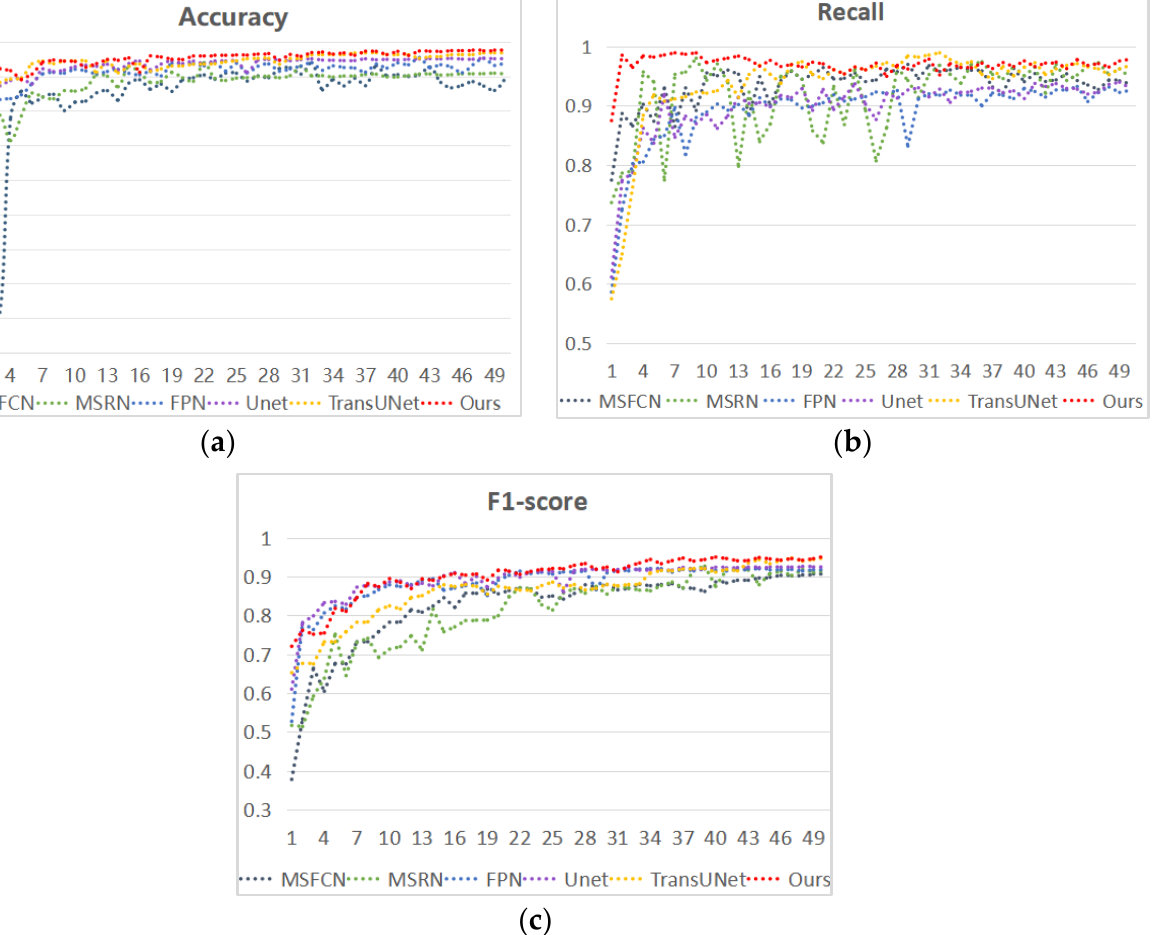
Figure 11. The trend of different metrics of each network during the training process. ( a ) is the trend of model accuracy, ( b ) is the trend of model recall, and ( c ) is the trend of model F1-score values.